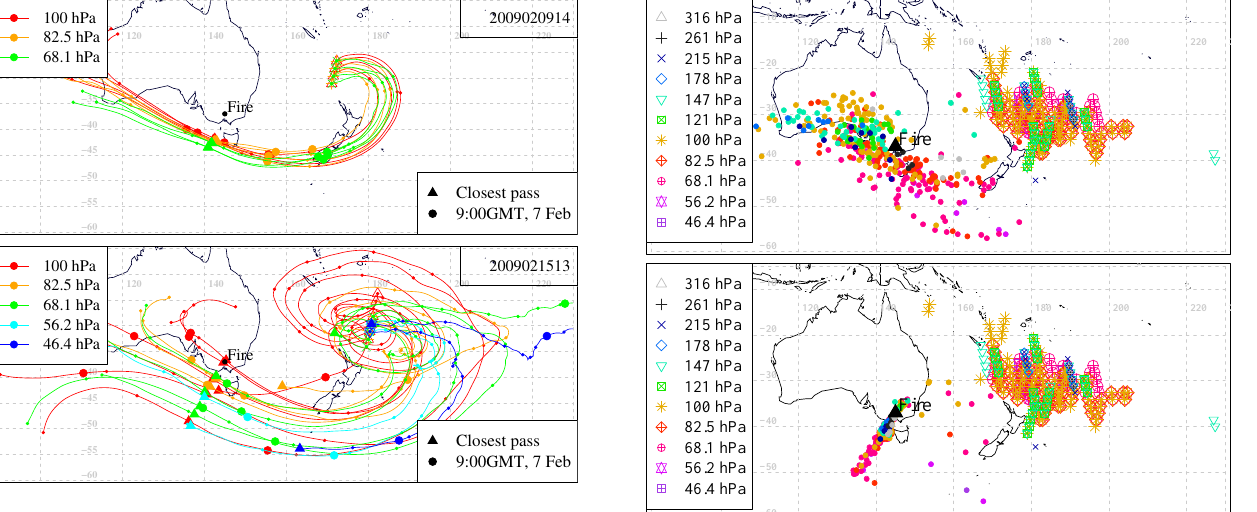
Fig. 9. Examples of back trajectories run from MLS measurement locations with elevated CO levels. The measurements in the top panel were made within 30 minutes of 14:00UTC on 9 February, while those in the bottom panel were made within 30 minutes of 13:00UTC on 15 February. (Starting date and UTC hour is shown on each panel in the form YYYYMMDDHH.) The small dots on the trajectories are placed at 24-h intervals.